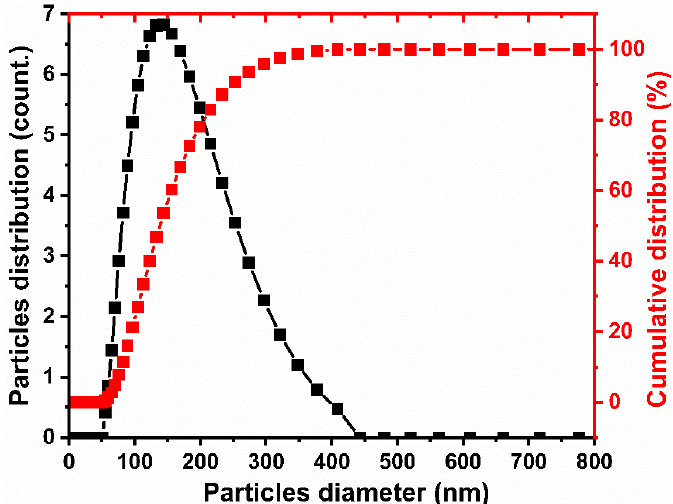
Figure 5. DLS spectrum of the MgO NBs.